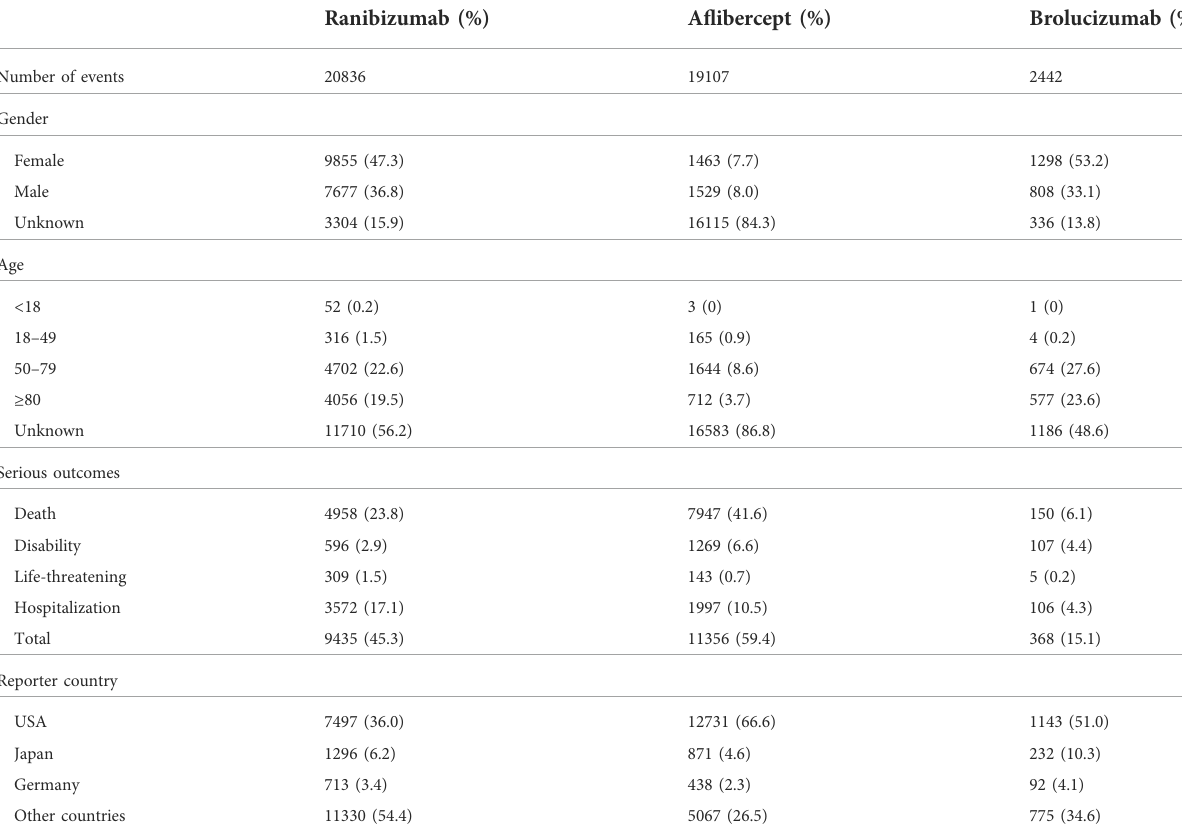
TABLE 3 Characteristics of reports associated with Anti-VEGF from Q1 of 2004 to Q3 of